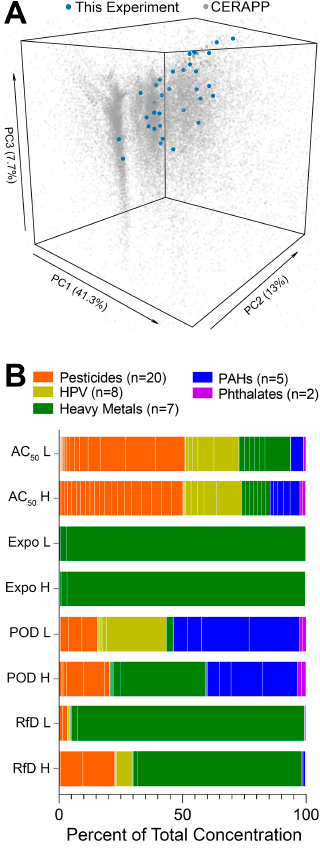
Figure 2. Diversity in the chemical structure of selected chemicals and defined mixture composition. ( A ) Principal component analysis (PCA) plot demonstrating the structural diversity of the chemicals tested in this study as compared to the representative environmental compound set included in the Collaborative Estrogen Receptor Activity Prediction Project (CERAPP, n = 32,464) [39]. We used 48 chemical descriptors (after omitting NA or constant descriptors) calculated using the open-source Chemistry Development Kit (implemented in the R package rcdk ) [40] to illustrate the spatial distri- bution of both datasets. Principal component analysis was conducted using prcomp from the R stats package, and visualization was conducted with the R plot3D package. The axes were truncated at the 95% confidence interval of each principal component. ( B ) Defined mixtures boxplots of the per- cent of total concentration for each individual chemical across eight defined mixtures. The boxplots are arranged by individual chemicals and chemical classes [orange = pesticides ( n = 20), yellow = HPV ( n = 8), green = heavy metals ( n = 7), blue = PAHs ( n = 5), purple = phthalates ( n = 2)].